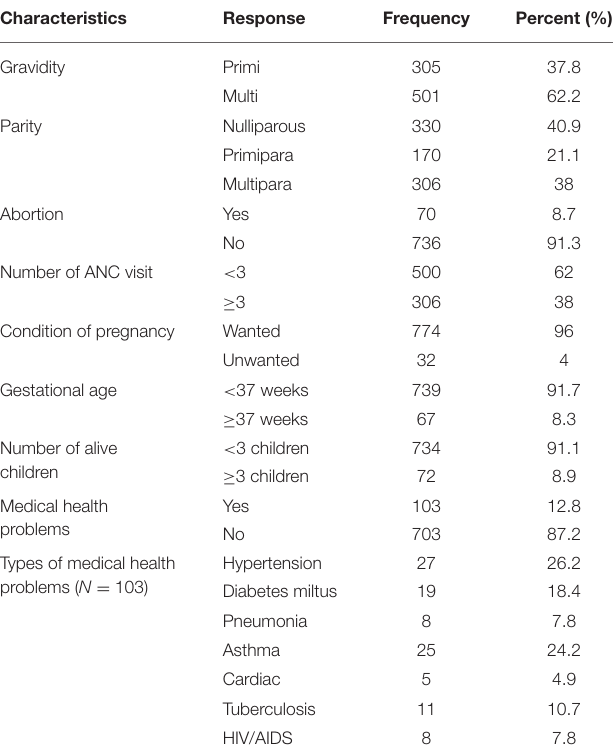
TABLE 2 | Obstetrical characteristics of pregnant women attending ANC during COVID-19 pandemic at public health facilities of East Gojjam zone, Amhara region, Ethiopia, 2020. ( n =